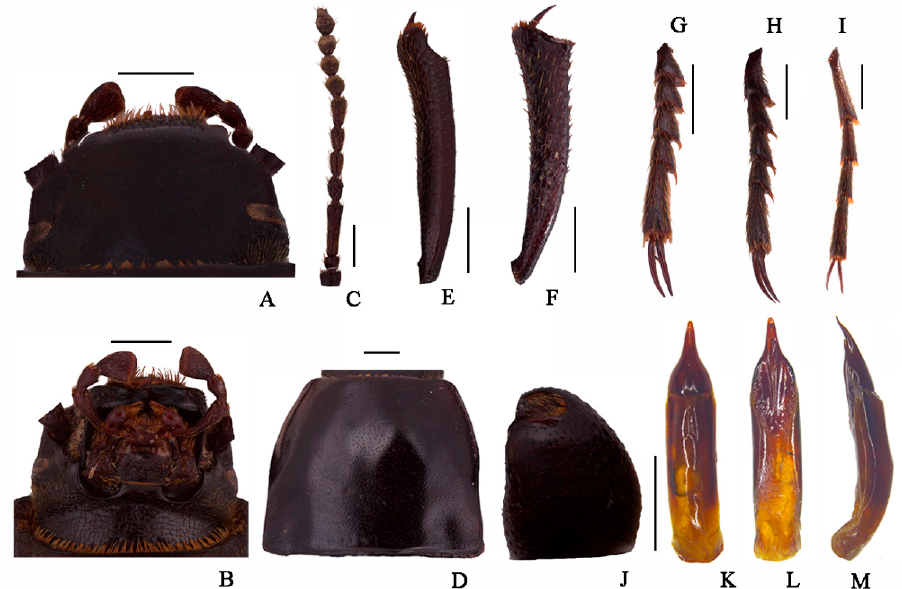
Figure 13. Nalepa acuminata Li & Ren sp. n. ( A ) head, dorsal view; ( B ) head, ventral view; ( C ) antenna; ( D ) pronotum; ( E ) protibia; ( F ) mesotibia; ( G ) protarsus; ( H ) mesotarsus; ( I ) metatarsus; ( J ) profemora; ( K – M ) aedeagus: ( K ) dorsal view; ( L ) ventral view; ( M ) lateral view. Scale bars: 1.0